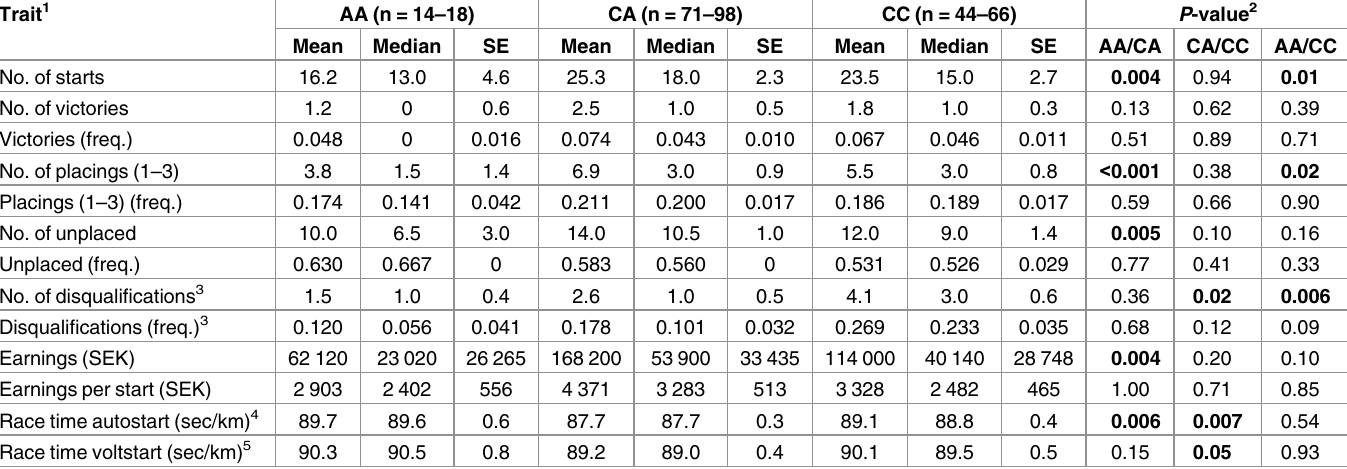
Table 4. Mean and median racing performance results for Coldblooded trotters at 7 to 10 years of age according to DMRT3 genotype (n = 182).